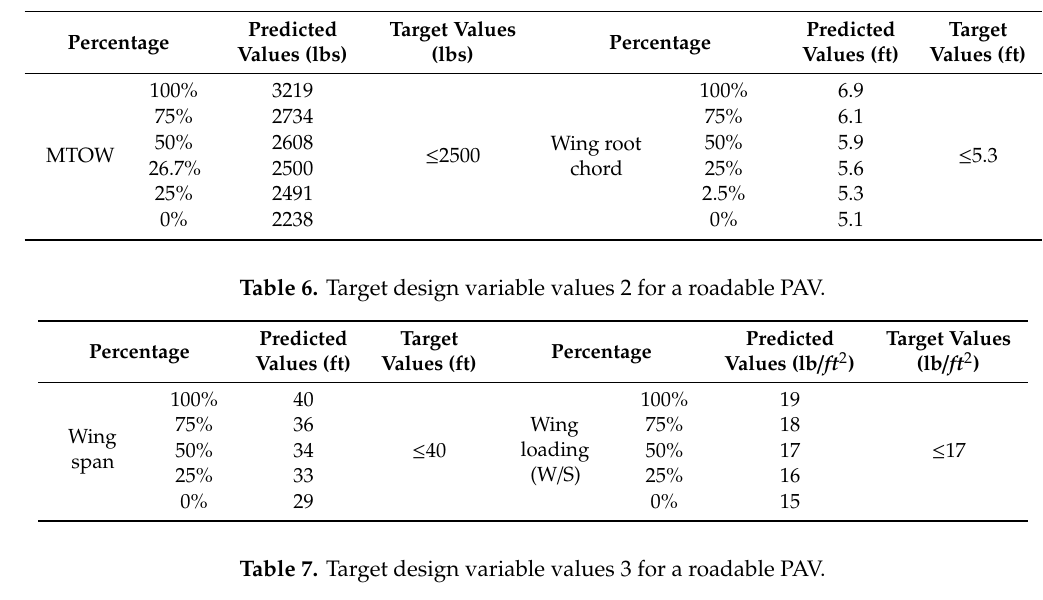
Table 5. Target design variable values 1 for a roadable PAV.